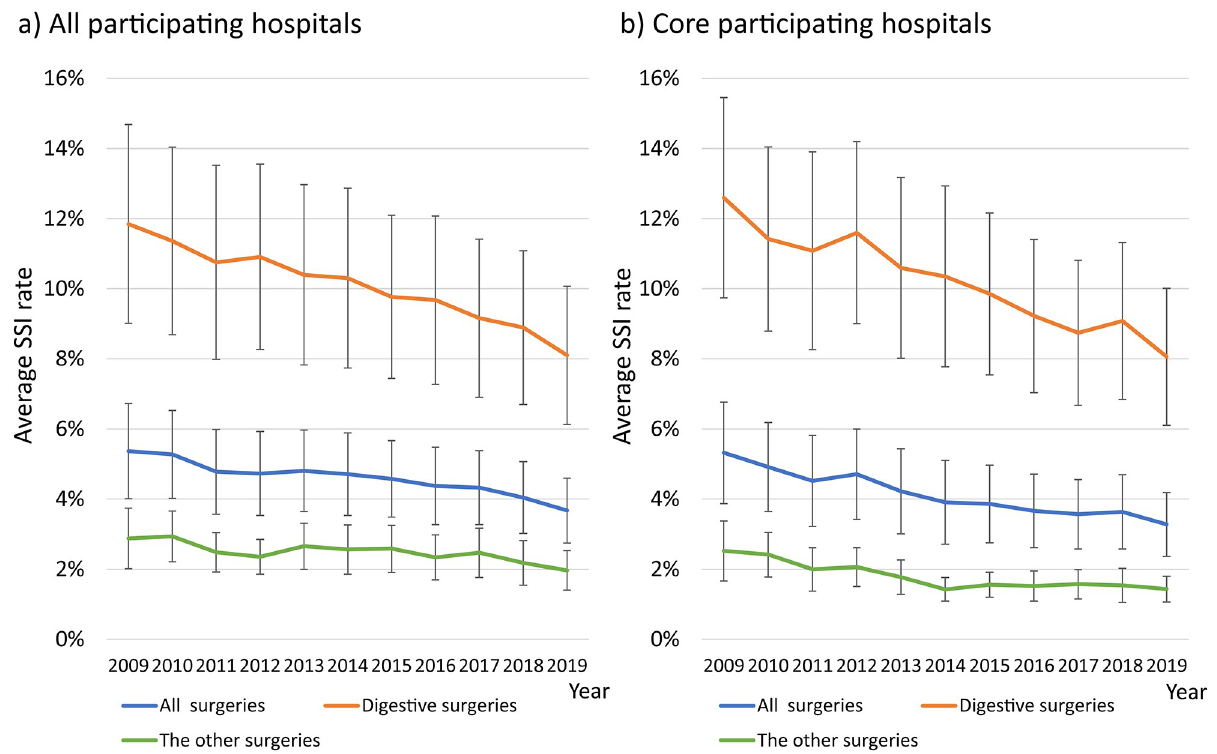
Fig 1. Proportion of surgical site infection for the five digestive surgeries and other surgeries. a) The proportion of surgical site infection in all participating hospitals. b) The proportion of surgical site infection in the core participating hospitals. The blue line shows the rate of surgical site infection for all types of surgeries. The orange line shows the rate of surgical site infection for five digestive surgeries (appendix surgery (APPY), gallbladder surgery (CHOL), colon surgery (COLO), small bowel surgery (SB), and rectal surgery (REC)). The green line shows the rate of surgical site infection for all except the five digestive surgeries. Error bars indicate standard